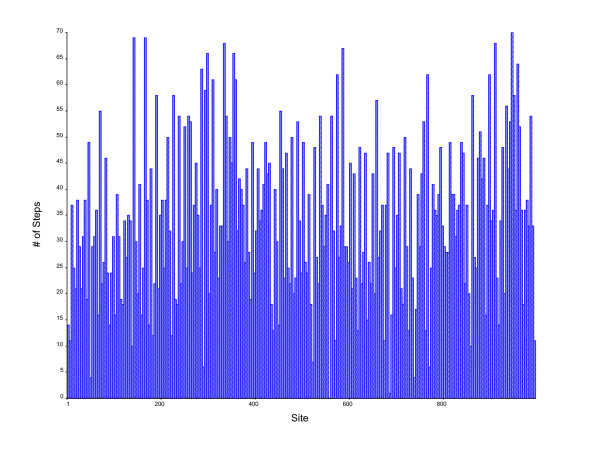
Pattern of nucleotide substitution in the coding regions of the plant GSK homologs based on the comparison of 116 sequences. The x-axis (site) was constructed based on 4-bp intervals.